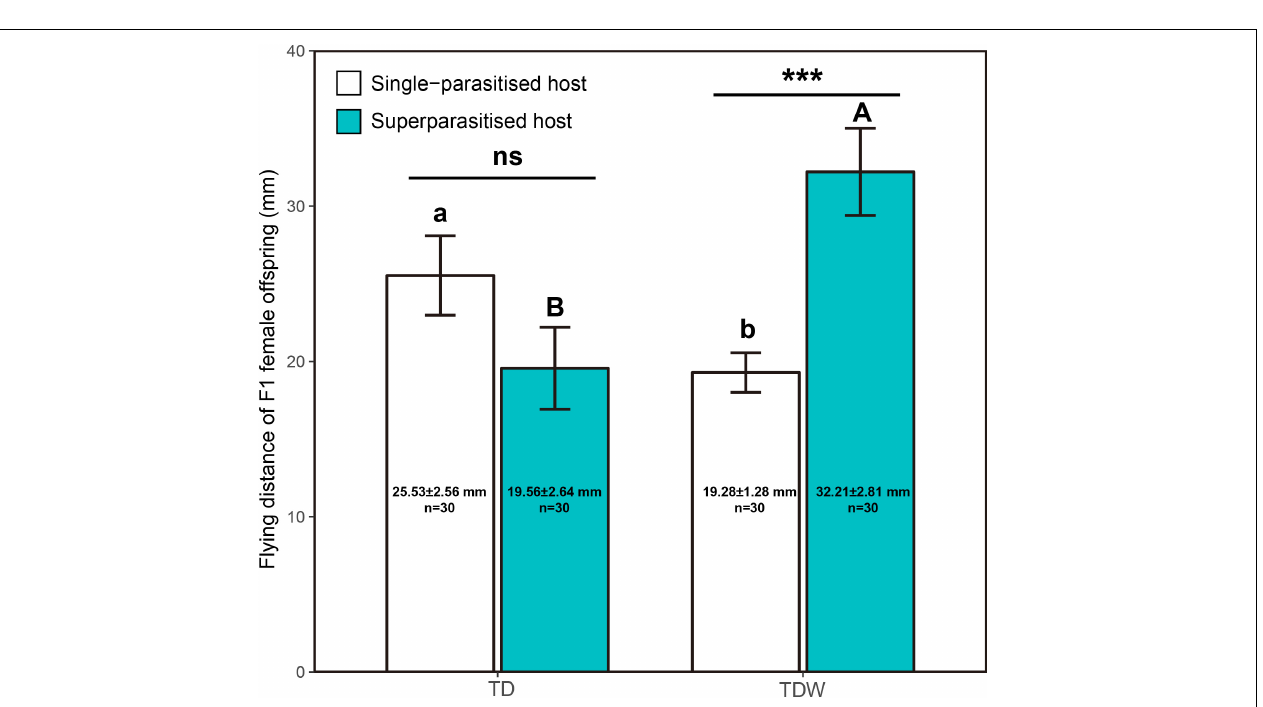
FIGURE 3 | Kaplan-Meier curve of adult survivorship and survival number of TDW (red) or TD (cyan) F1 female offspring in single-parasitised (S1) or superparasitised (S2) hosts with the time extended.